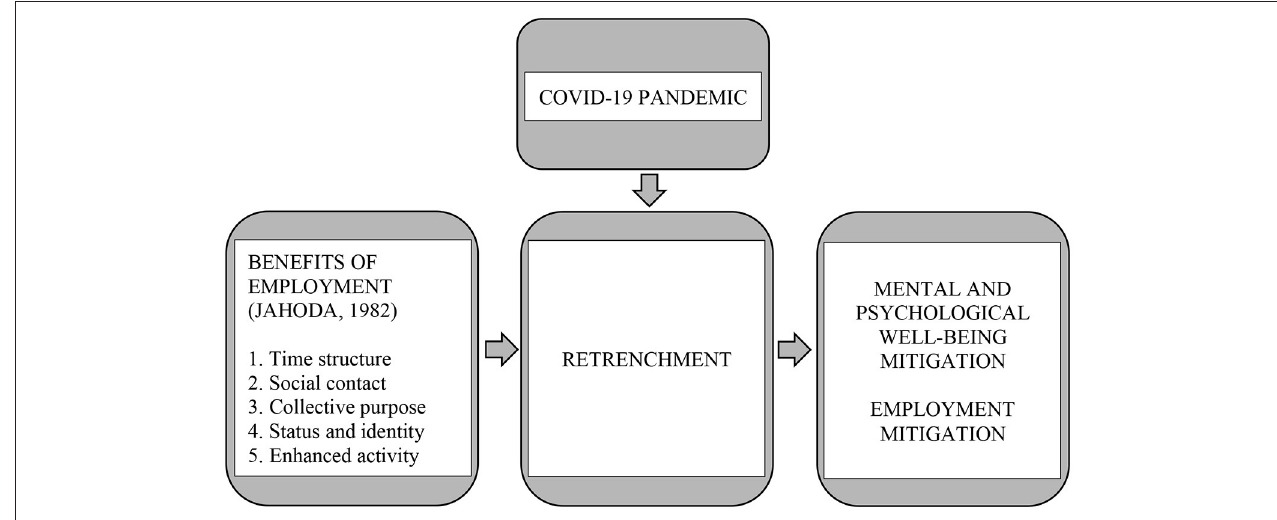
FIGURE 1 | Conceptual model.